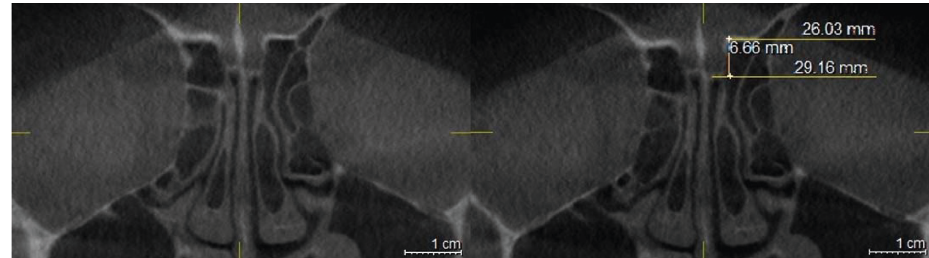
Figure 2: Coronal plan of CBCT demonstrating type 2 Keros classification on the left side.